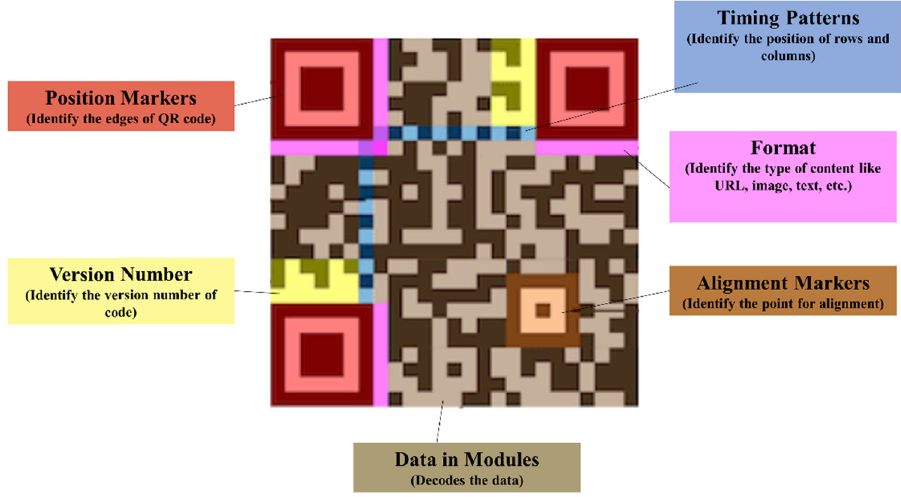
Figure 1: Basic building blocks of QR code